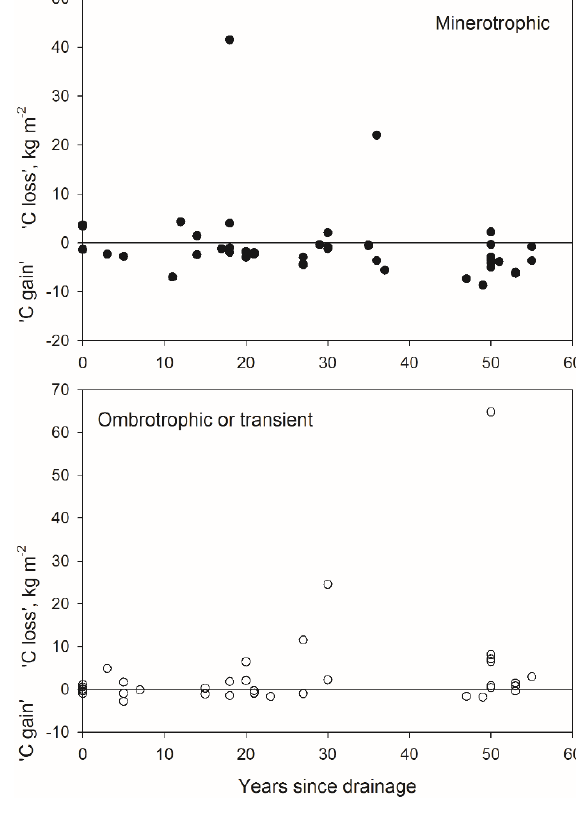
Figure 8. Carbon (C) loss or gain (kg m -2 ) in the 0– 20 cm peat layer estimated by subtracting the (Figure 8). measured C content from the expected C content, estimated for each site from its peat ash content and the average value of C/ash for the undrained sites (Equations 1 and 2), as is done when applying the ash method using reference sites (e.g., Kareksela et al. 2015). Sites as in Figure